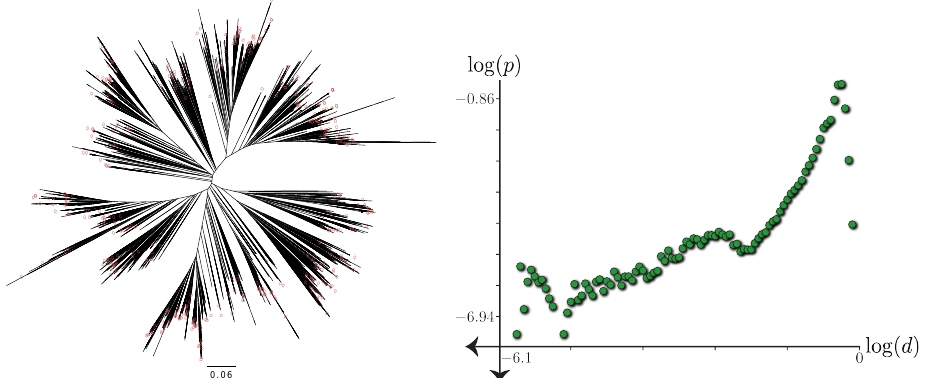
Figure 2. Left : The 7797-taxon reference tree adopted from Zhu et al. [7] restricted to sequences with 16S available with normalized lengths and query taxa noted. Right : The log-log scatter plot (base 10) for the histogram of pairwise tree distances d versus relative frequencies p